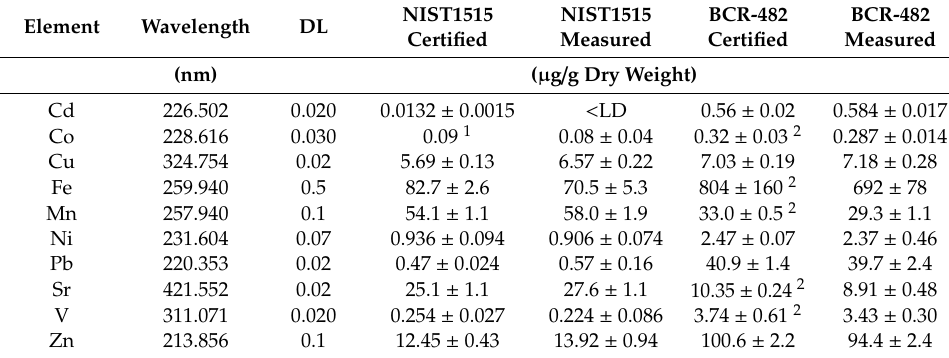
Table 3. Quality control performed with the two standard reference materials used, NIST1515 ( n = 7) and BCR-482 ( n = 4).For each element the measured concentrations (mean ± standard deviation) are compared with the certified values (mean ± half-width of the 95% confidence interval) or with the reference values (mean ± standard deviation) indicated in the certification reports. All concentrations are expressed in µ g / g dry weight. Concentration below the detection limit is indicated as < DL. The wavelengths (nm) used in this study and the detection limit (DL) of the method (based on 3 times the standard deviation of blanks, expressed as µ g / g dry weight) are also reported.